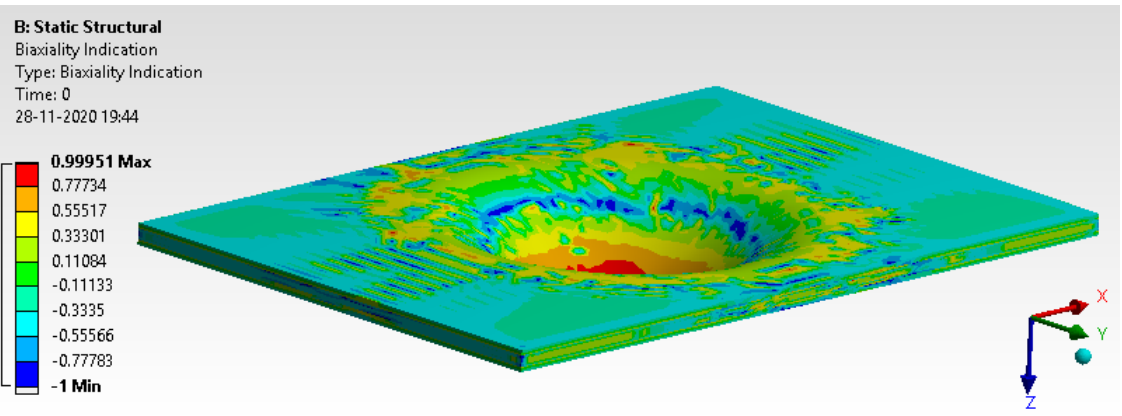
Figure 25. Bi-axiality indication.